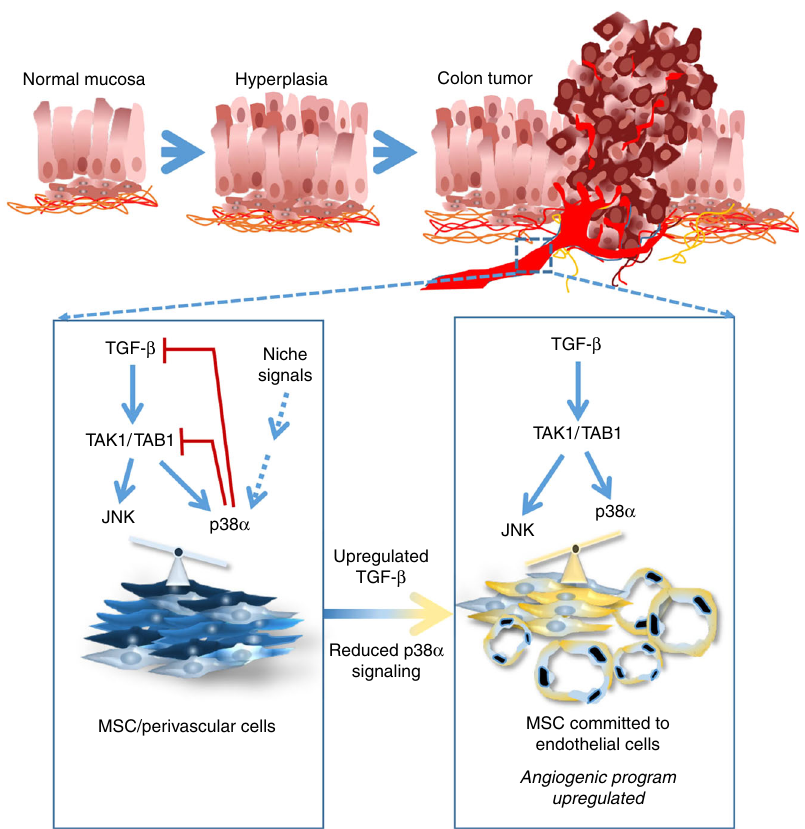
Fig. 9 Schematic illustration of the interplay between p38 α and TGF- β /JNK signaling that regulates angiogenic cues and cell fate decision of mesenchymal/ perivascular cells in injured tissues and tumors. See main text for